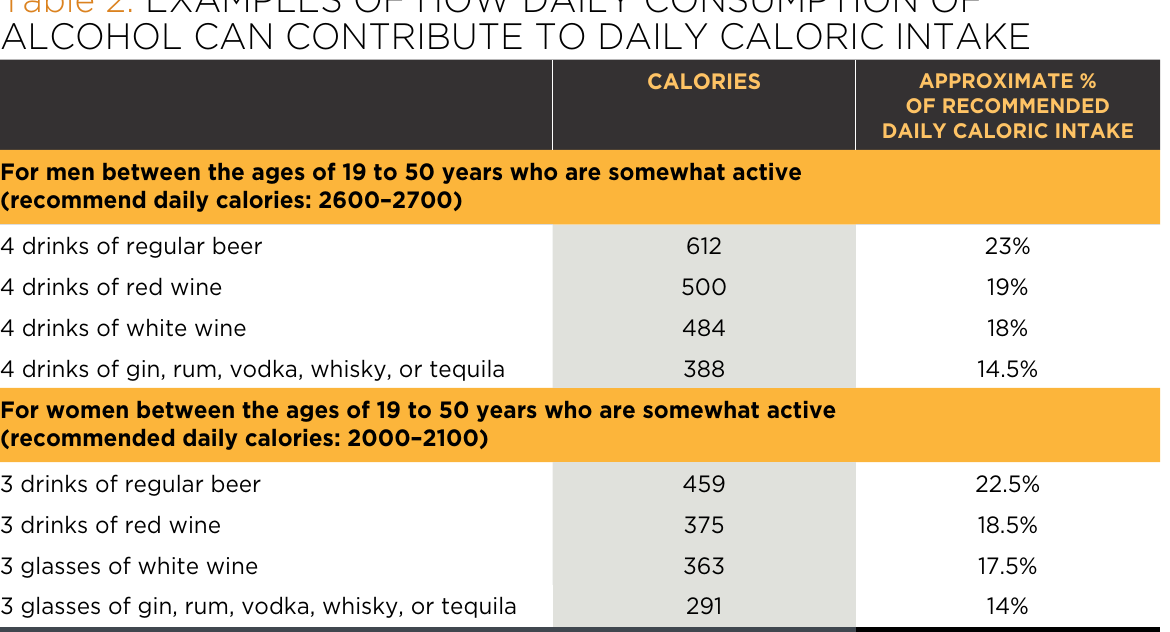
Table 2: EXAMPLES OF HOW DAILY CONSUMPTION OF ALCOHOL CAN CONTRIBUTE TO DAILY CALORIC INTAKE CALORIES APPROXIMATE % OF